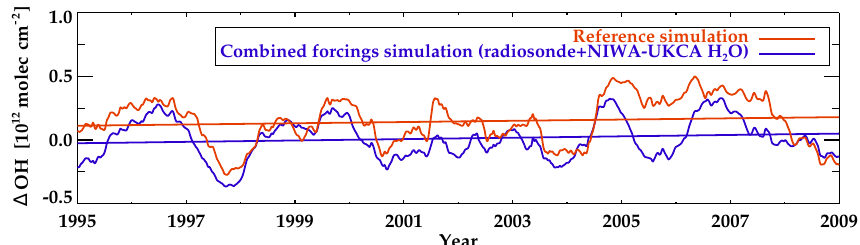
Figure 11. Variability and trend of the OH column anomaly. The red solid line is the time series of the reference simulation and the blue solid line is the combined forcings simulation considering radiosonde – NIWA–UKCA H 2